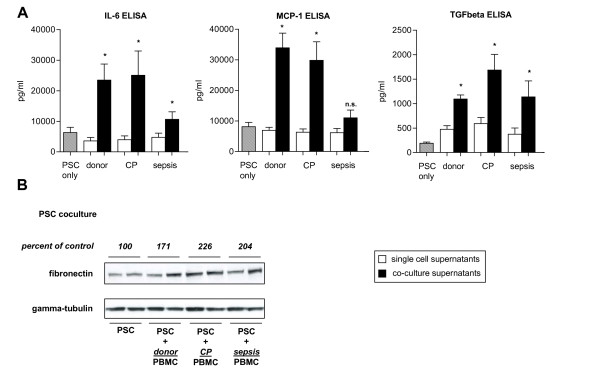
Analysis of PSC supernatants and cell lysates following coculture with PBMC. (A) PSC cell culture supernatants were subjected to ELISA following coculture with donor, CP and sepsis PBMC. Hatched bars: PSC supernatants. White bars: Pooled donor, CP or sepsis PBMC and corresponding PSC supernatants. Black bars: coculture supernatants. *p < 0.05 as assessed using the Mann-Whitney U test. (B) Immunoblot analysis of fibronectin in PSC cell lysates. Densitometry shown as percent of control adjusted to the corresponding gamma-tubulin density.